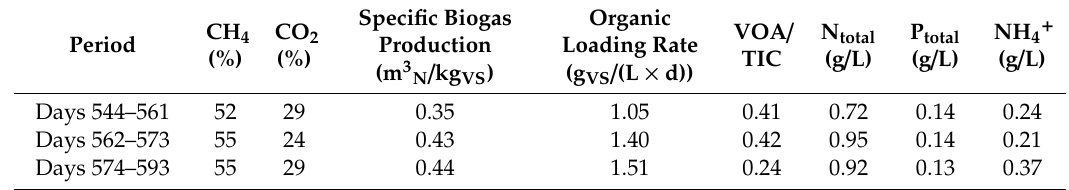
Figure 4. Acetic, propionic, and isovaleric acid concentrations and biogas composition of the continuous biogas process (40 °C; pH 7.0–8.0, lot B). The days of macronutrient and trace element supplementation are marked. Table 4. Average process parameters of the periods: days 544–561, days 562–573, and days 574–593 (40 °C; pH 7.0–8.0; fed with energy cane (lot B)).